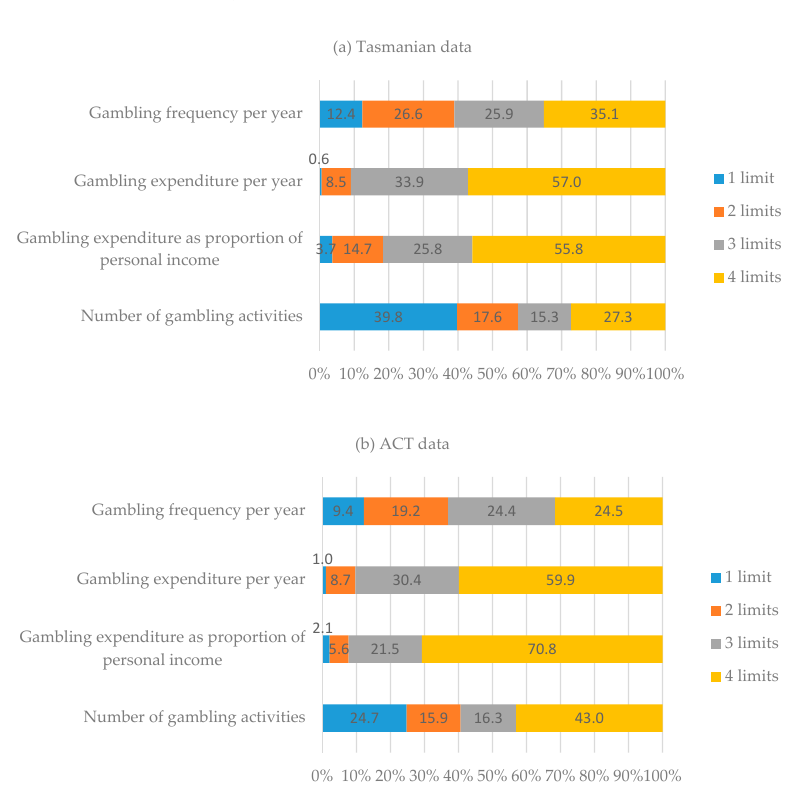
Figure 1. Proportion of gamblers exceeding multiple low-risk gambling limits a ( a ) in Tasmania; ( b ) in Australian Capital Territory (ACT). a Endorsement of two or more PGSI negative consequence items selected as definition for derivation of low-risk gambling